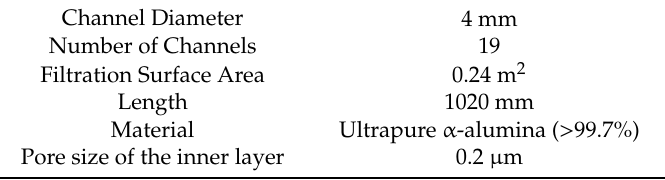
Figure 1. ( a ) Schematic of the plant used for MF tests: V1-9 ball valves; GV gate valve; P1,2 manometers, T thermometer; F flowmeter. ( b ) Membralox module: 1—ceramic multi-channel membranes, 2—stainless steel membrane housing, 3—module end-cup, 4—clamps. Table 2. Main properties of Pall–Membralox EP19-40 membrane used for MF tests.